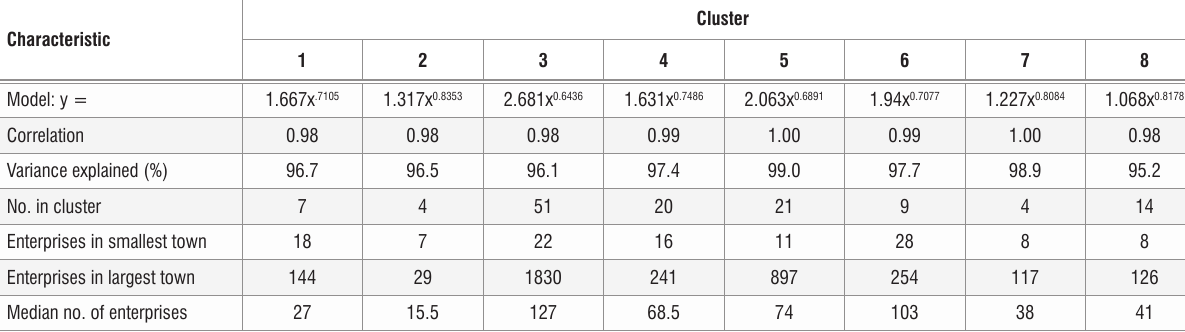
Cluster relationships between enterprise richness and enterprise numbers and other